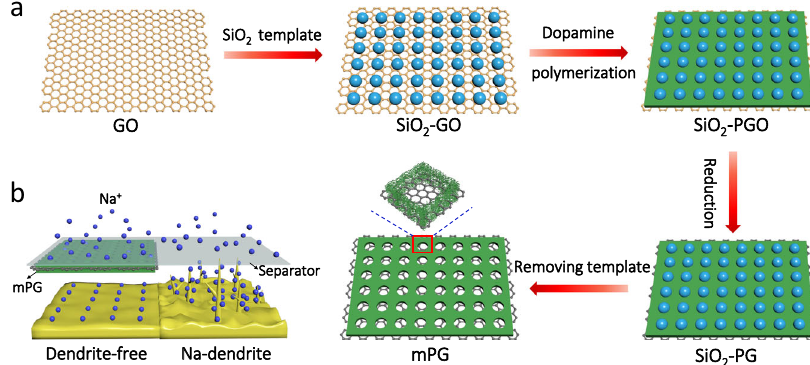
Fig. 1 Scheme of s-2D mPG heterostructures for dendrite-free Na metal anode. a Schematic of the fabrication of s-2D mPG heterostructures, and b diagram of Na deposition behaviors with bare PP separator and mPG-coated PP